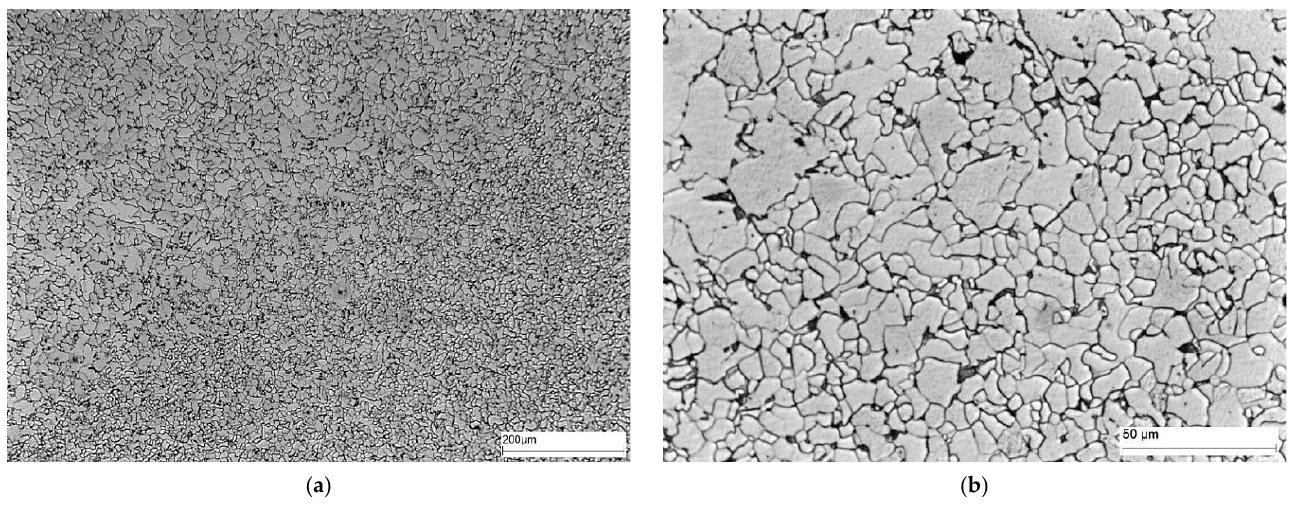
Figure 15. Microstructure of area B of welded joint—HAZ: ( a ) magnification 100×, and ( b ) magni- fication 500×. Ferrite—white precipitates, and perlite—dark precipitates at the ferrite grain boundary. The microstructure of area C, i.e., the fusion boundary, is shown in Figure 16. In this area, Widmanstätten ferrite (light) and bainite (dark) precipitates occur on the weld side. Ferrite (light) and bainite (dark) precipitates with different morphology are also present on the HAZ side.